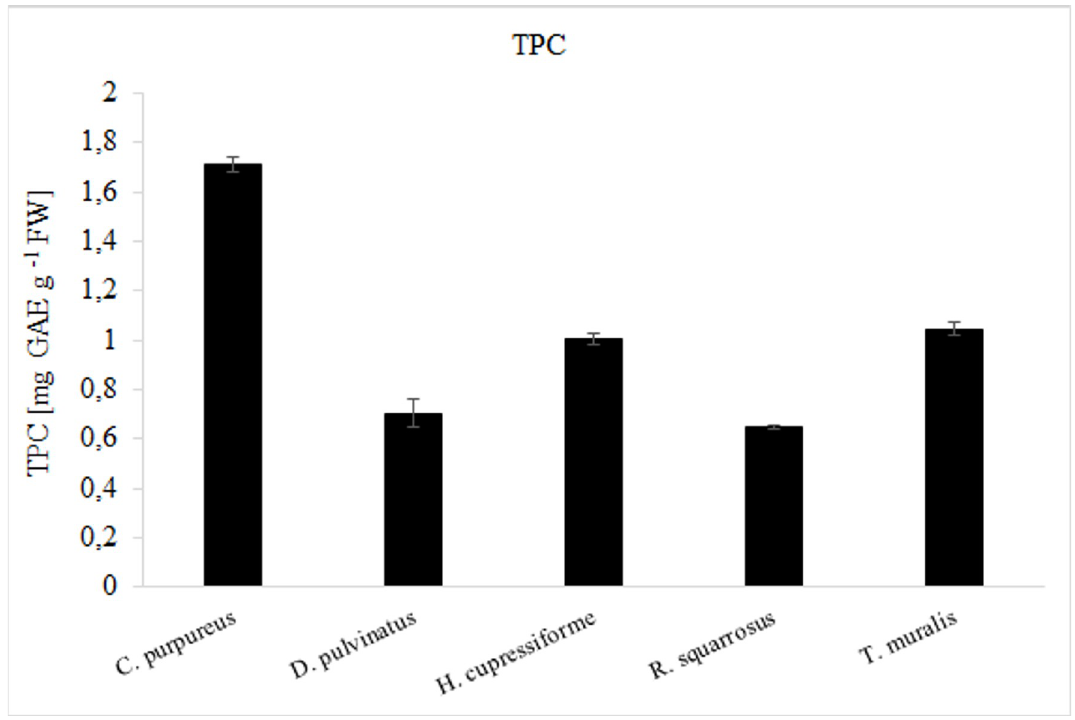
Fig 2. The total phenolic content of selected mosses expressed as mg gallic acid equivalent per g of fresh sample. The results are expressed as mean values of 3 independent experiments ± SD.